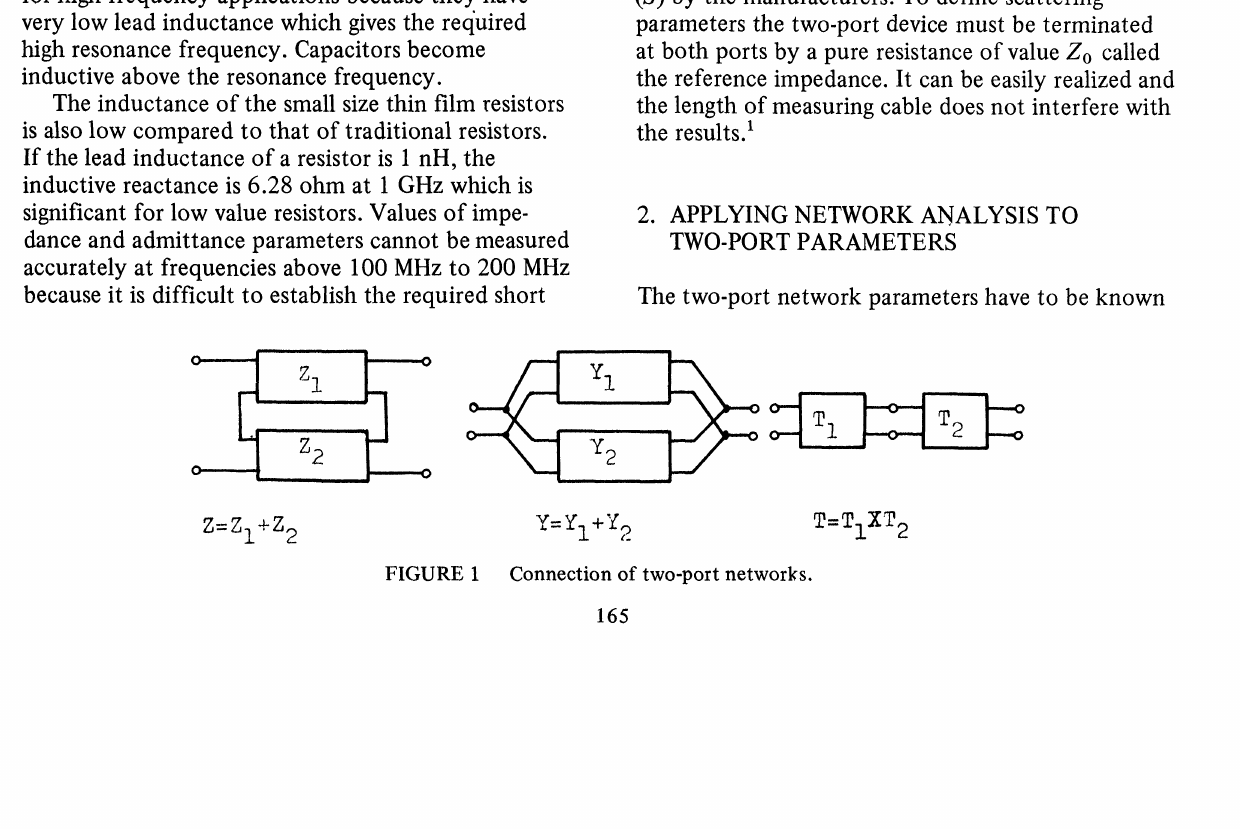
Y=ZI+Y 2 Connection of two-port